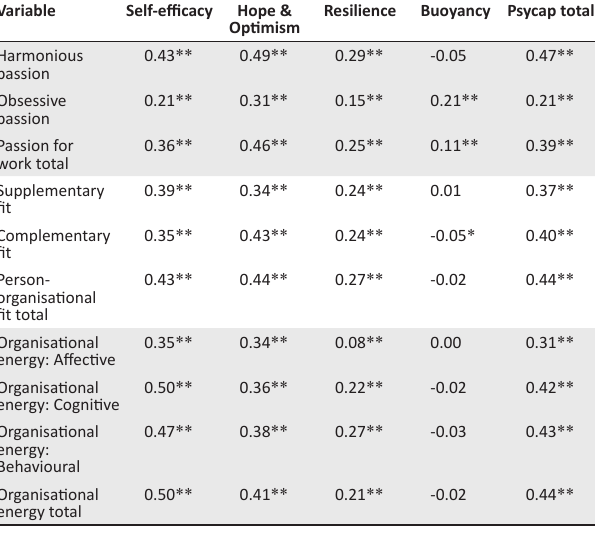
TABLE 13: Convergent validity of the adapted (reconfigured) Psychological Capital Questionnaire factors by means of correlations (Pearson) with other related